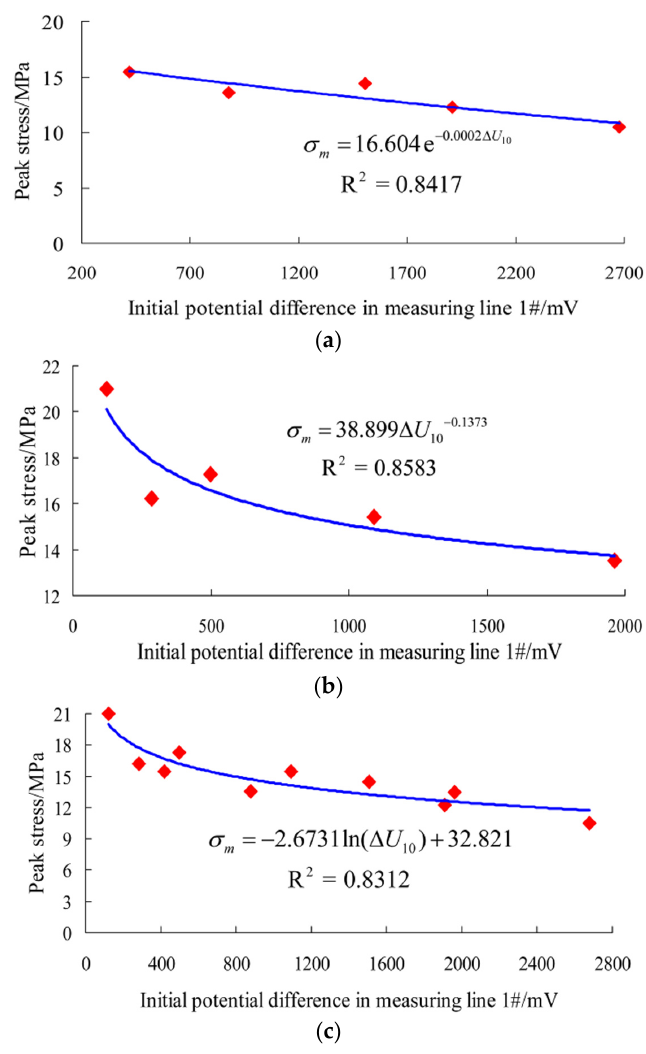
Figure 9. Relation curves between the peak stress and the initial potential difference in measuring line 1#. ( a ) Rock samples parallel to the bedding direction; ( b ) Rock samples normal to the bedding direction; ( c ) All samples.